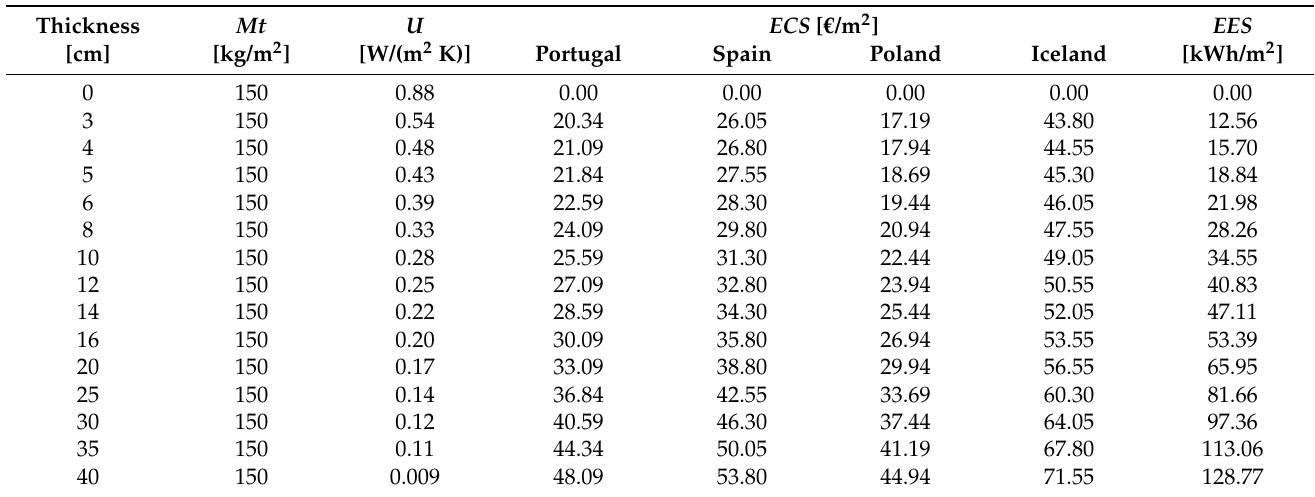
Table 5. Useful thermal mass ( Mt ) and thermal transmission coefficient ( U ) of the exterior walls and the respective economic cost ( ECS ) and embodied energy ( EES ) of the thermal insulation